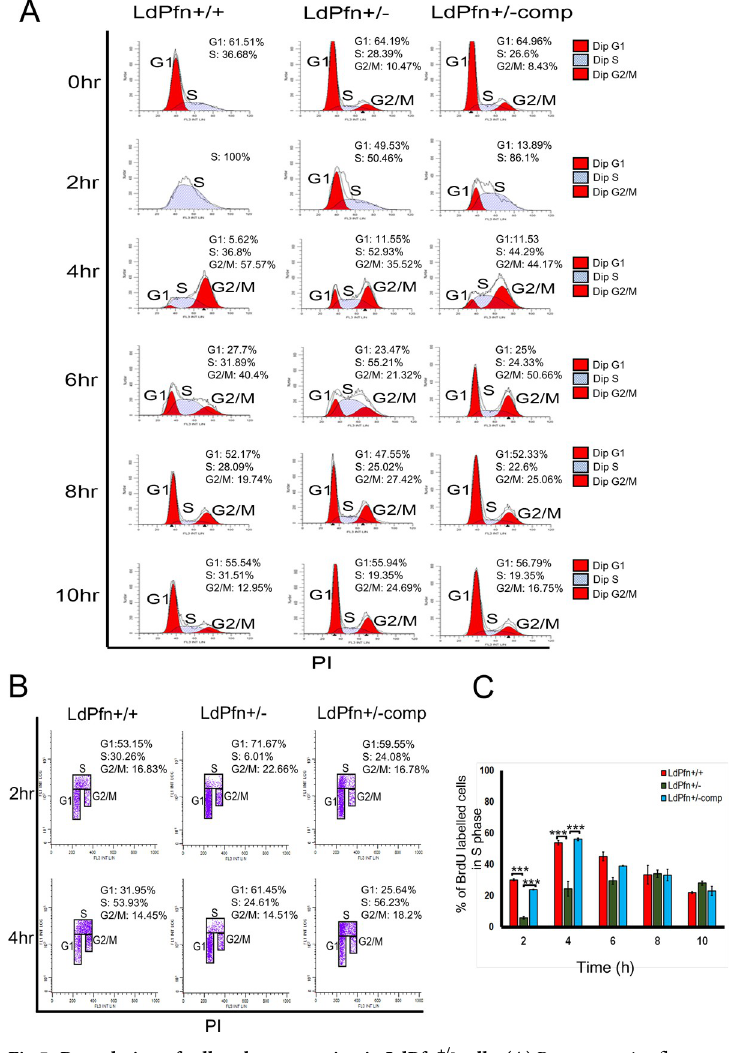
Fig 5. Retardation of cell cycle progression in LdPfn +/- cells. (A) Representative flow cytometry data of LdPfn +/+ , LdPfn +/- and LdPfn +/-comp cells. The samples were collected, after releasing hydroxyurea (HU) block, at 2 hours interval for up to 10 hours. 20,000 events were analysed at every time-point. Three independent experiments were performed, and one representative dataset is shown here. G1 (first red peak), S (grey peak) and G2/M (second red peak) phases are indicated in the histogram itself along with percent of cells in each phase. LdPfn +/+ cells entered into S-phase at 2 hours after release of HU block. However, transition of LdPfn +/- cells from G1- to S-phase was considerably delayed, compared to LdPfn +/+ and LdPfn +/-comp cells. (B) Representative flow cytometry data with BrdU incorporation in LdPfn +/+ , LdPfn +/- and LdPfn +/-comp cells. The cells were collected, after releasing the HU block, at 2 hours interval for up to 10 hours, and then labelled with anti-BrdU antibodies, as described in ‘Materials and Methods’. 10,000 events were analysed at every time-point. Three independent experiments were performed, and one representative dataset of 2 hours and 4 hours is shown. G1, S and G2/M phases are indicated in the histogram along with the percent of cells in each phase. In LdPfn +/- cells, a significantly lesser number of cells (6.01% and 24.61%, respectively, at 2 hours and 4 hours after releasing HU block) exhibited BrdU incorporation in S-phase, as compared to LdPfn +/+ cells (30.26% and 53.93%, respectively, at 2 hours and 4 hours after releasing HU block), and LdPfn +/-comp cells (24.08% and 56.23%, respectively at 2 hours and 4 hours after releasing HU block). (C) Bar diagram showing considerably lesser number of BrdU labelled LdPfn +/- cells (green bar) in S-phase at 2 hours and 4 hours after releasing the HU block, compared to LdPfn +/+ cells (red bar) and LdPfn +/-comp cells (blue bar) at the same time points. p-value ��� < 0.001 at both 2 hours and 4hours after releasing the HU